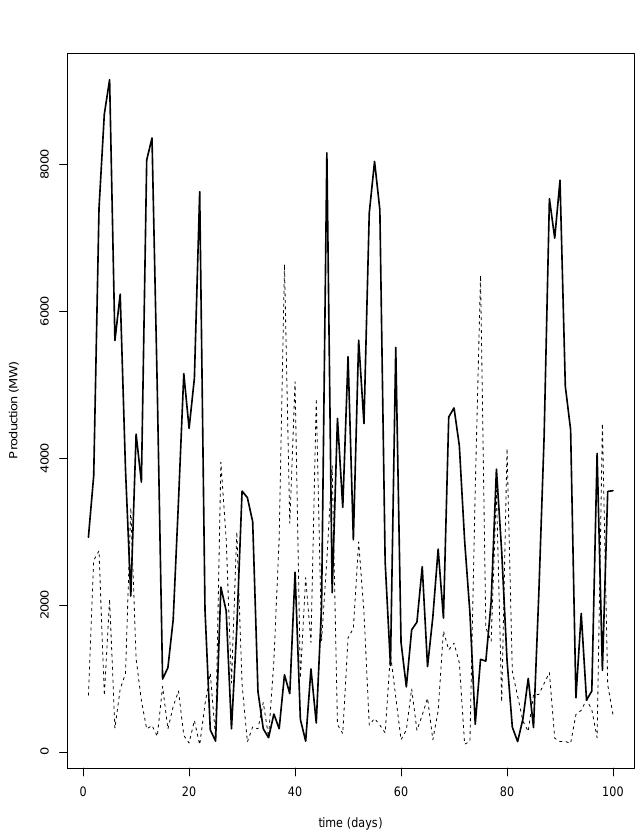
Figure 4. Power production time series (bold line) and power production obtained by the Betz law (dotted line), with respect to the first one hundred